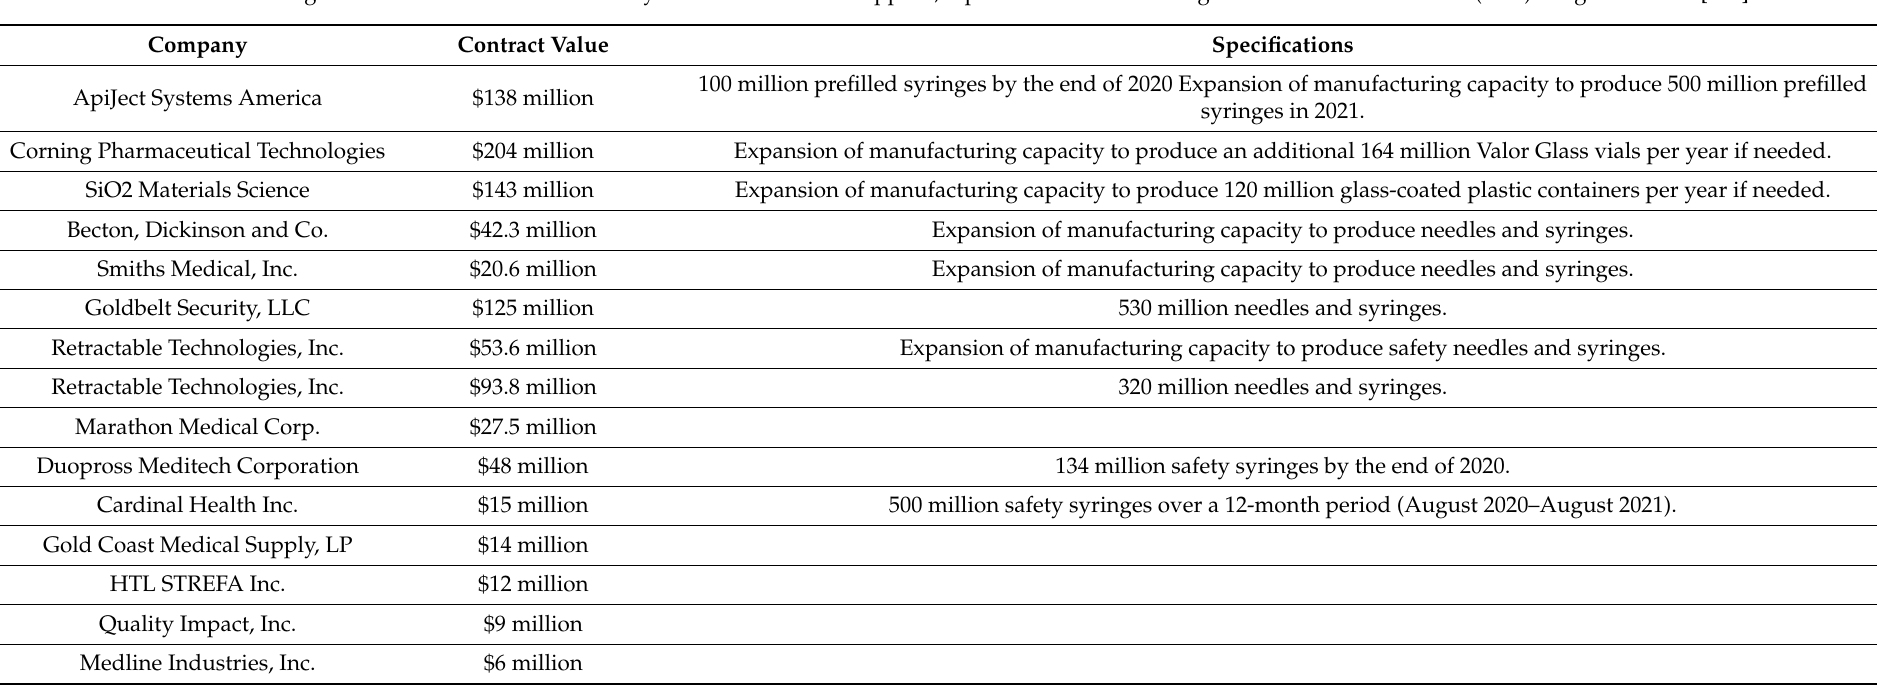
Table 7. Federal governments contracts for ancillary COVID-19 vaccine supplies, reproduced from the Congressional Research Service (CRS) Insight IN11560 [108].